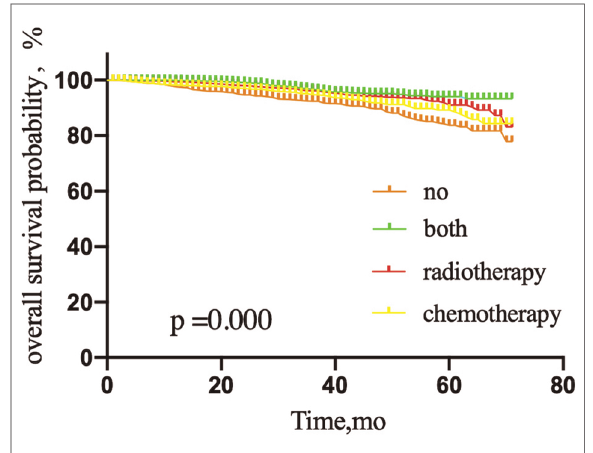
FIGURE 7 Overall survival probability of patients with micrometastases in 1 or 2 sentinel lymph node micrometastases treated with sentinel lymph node biopsy alone, according to adjuvant therapy. NO patients treated with no adjuvant therapies; BOTH patients treated with both adjuvant chemotherapy and radiotherapy; RADIOTHERAPY patients treated with adjuvant radiotherapy; CHEMOTHERAPY patients treated with adjuvant chemotherapy.